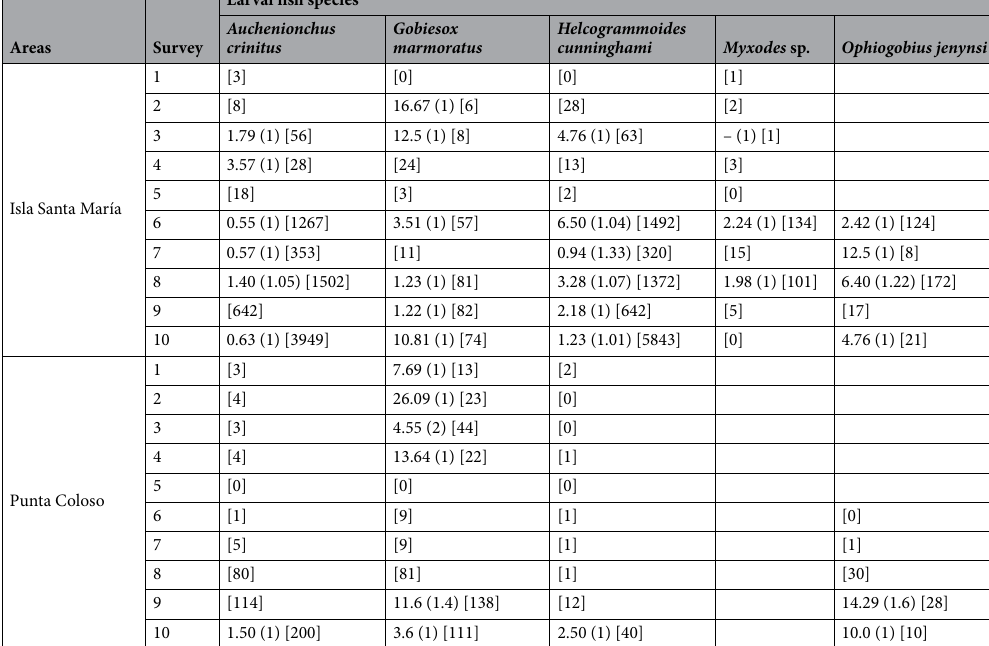
Table 1. Prevalence and mean intensity of larval copepods ( Trifur sp.) found on five different fish larvae species collected from Isla Santa María and Punta Coloso during austral spring–summer (1–5) and autumn– winter (6–10) in northern Chile. In square parenthesis indicate number of larval fish collected in the respective survey.